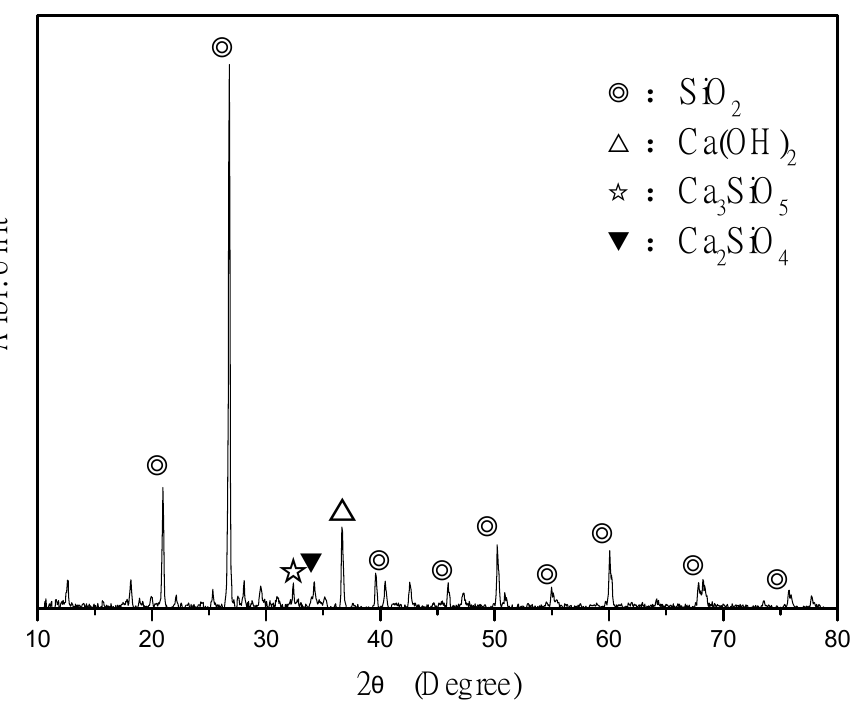
Figure 17. Chemical composition of ICM 5 mm below the coating layer, as determined through XRD.